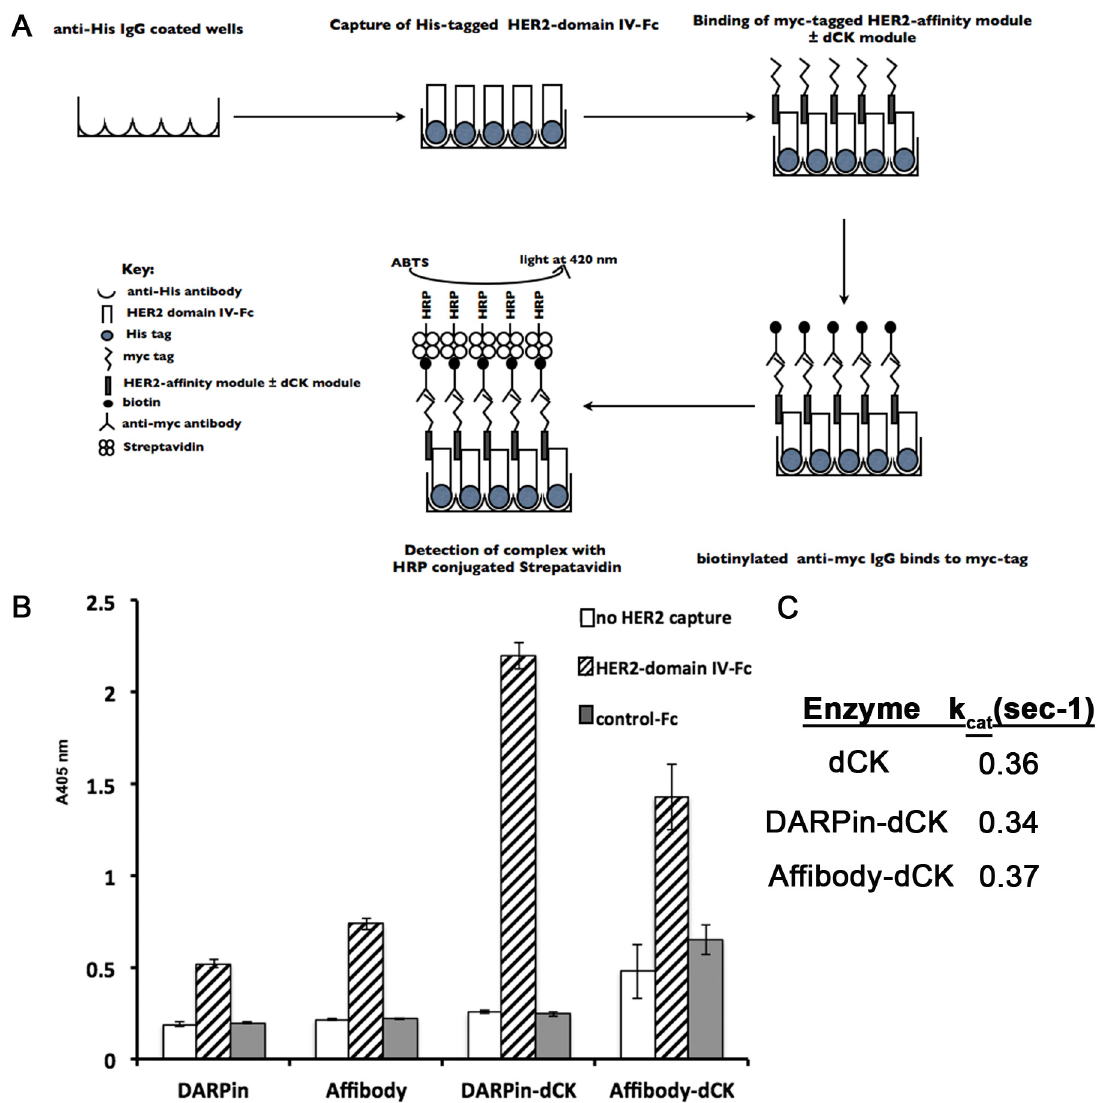
Fig 2. Characterizing individual anti-Her2 modules and the bi-modular anti-Her2-dCK fusion proteins. (A) Schematic of the ELISA assay used to evaluate the binding of the affinity reagents to the ectodomain IV of the Her2 receptor. (B) Binding of reagents to the ectodomain IV of Her2 receptor was measured by incubating 50 nM of reagents with 20 nM of immobilized Her2-Fc recombinant protein. Detection was performed using biotinylated anti-c-myc antibody and streptavidin conjugated to Horseradish peroxidase (HRP). Error bars represent standard deviation of triplicate measurements. We interpret the increased ELISA signal for the fusion proteins relative to the individual affinity modules resulting from the dimeric nature of the fusion proteins. (C) The observed steady state phosphorylation rate (k obs ) of fludarabine by the engineered dCK (dCK-DMS74E) with, or without, the Her2-affinity modules is measured with 200 μ M of fludarabine at 37°C. These measurements indicate that the affinity modules do not interfere with the dCK enzymatic